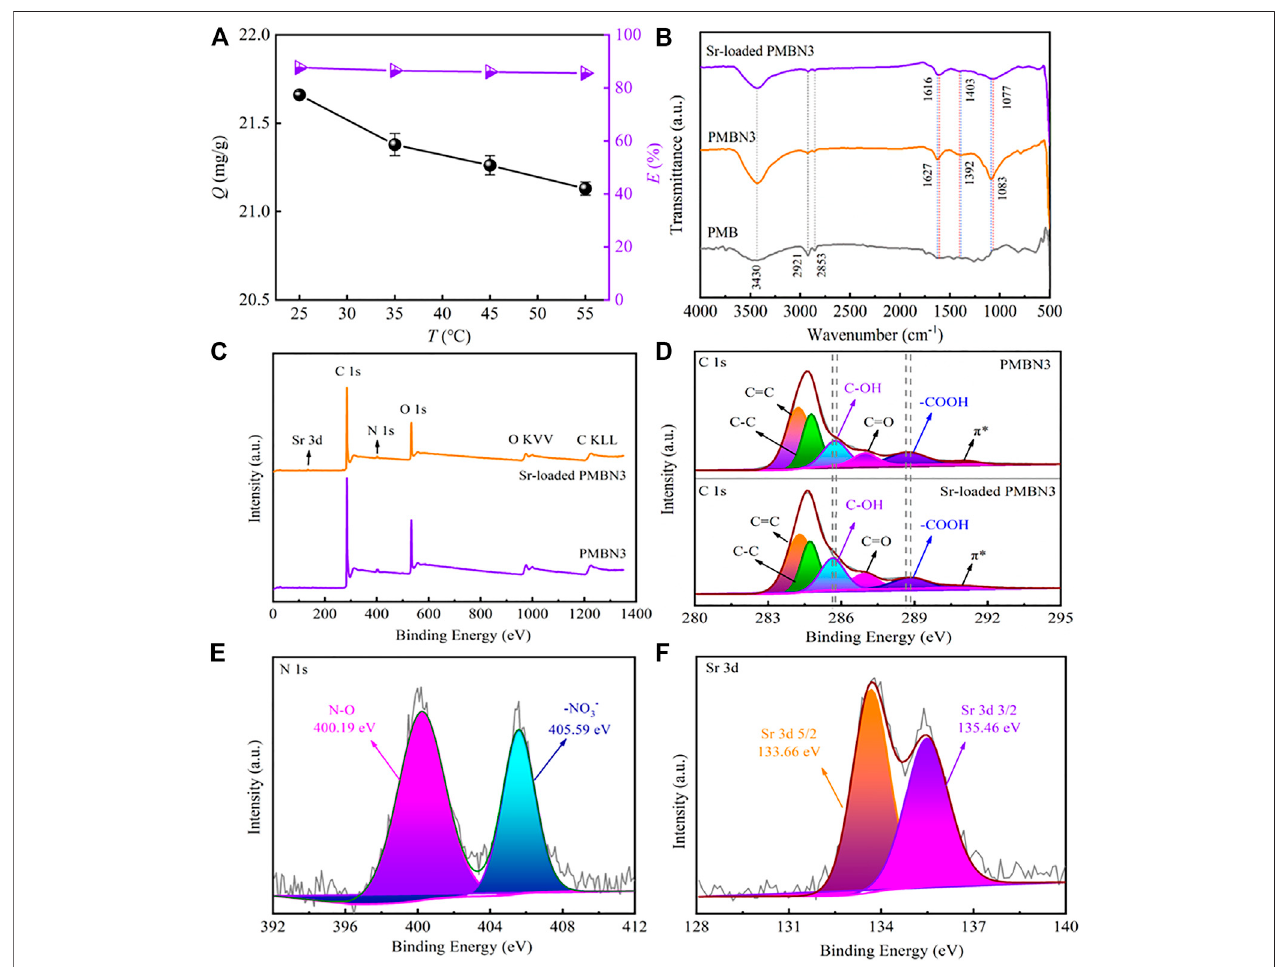
FIGURE 5 | (A) Effect of temperature on Sr(II) adsorption ( C o : 50 ppm , m / v : 2 g/L, pH: 8, t : 3 h, r : 120 rpm), (B) FTIR spectra of PMB, PMBN3 and Sr-loaded PMBN3, (C) XPS survey scans of PMBN3 and Sr-loaded PMBN3, (D) XPS spectra of C 1s, (E) XPS spectra of N 1s, (F) XPS spectra of Sr 3 days.